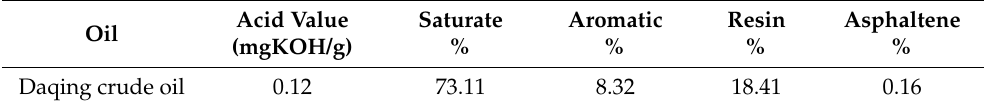
Table 2. The properties of Daqing crude